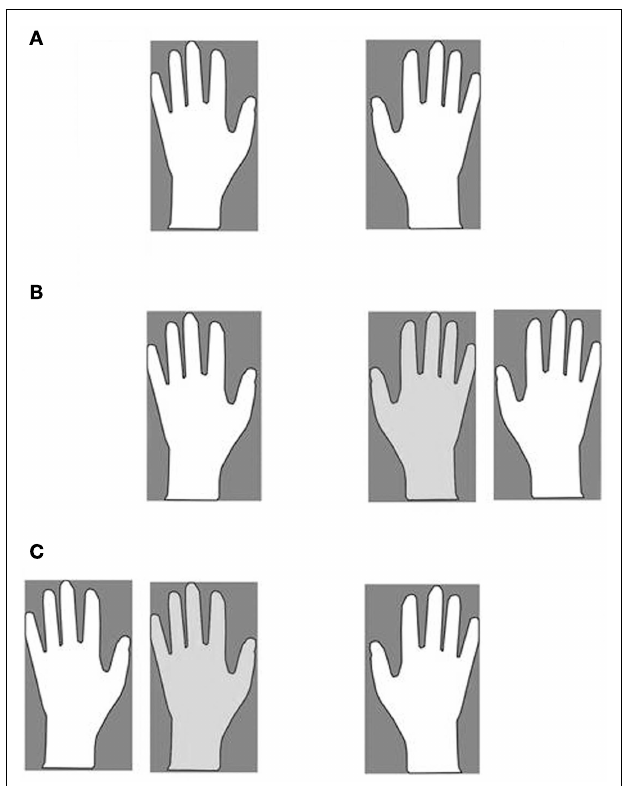
FIGURE 1 |The four experimental conditions . Own (A) and Alien (B,C) . Participant’s hands (white), co-experimenter’s hand (light gray).